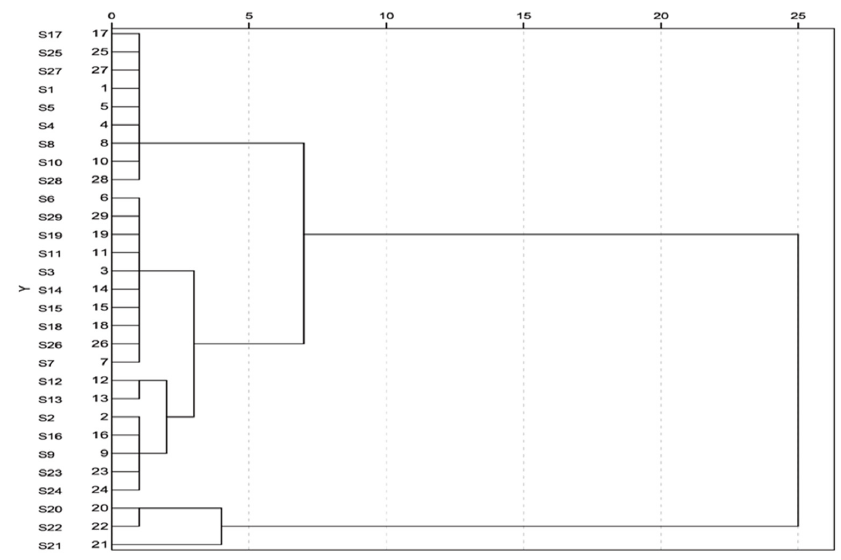
Figure 4. Dendrogram using Average Linkage (between Groups) Rescale Distance Cluster Combine.